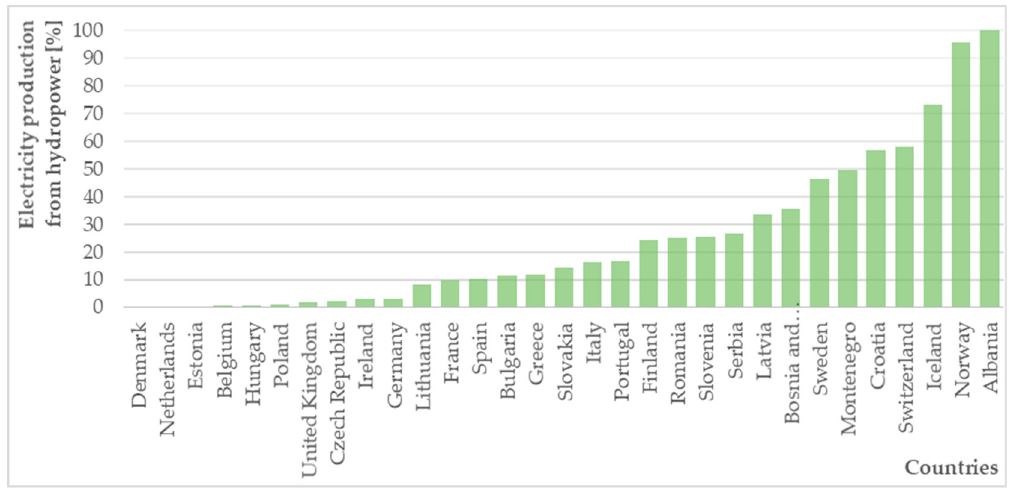
Figure 1. Domestic electricity production from hydropower in selected European countries